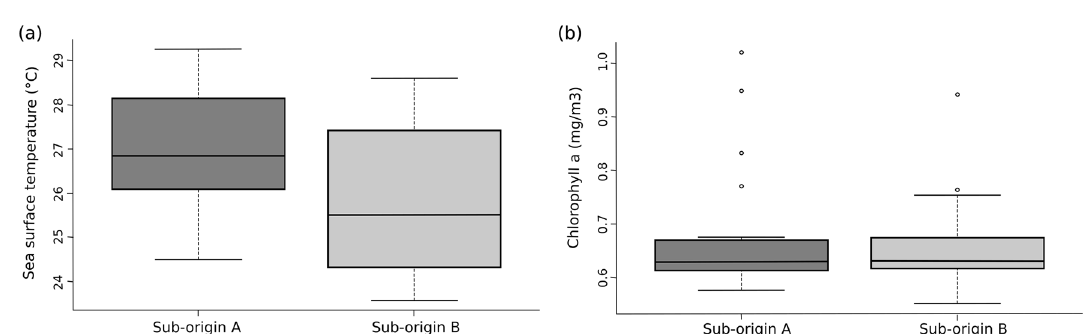
Figure 5. Ternary plots showing morphotype composition of Sargassum samples stranding in Barbados over a 12-month period. Part ( a ) shows Sargassum samples from sub-origin/transport pathway A (March–early August). Part ( b ) shows Sargassum samples from sub-origin/transport pathway B (late August–February). Sargassum natans I (SNI), S. natans VIII (SNVIII) and S. fluitans III (SFIII). Samples are represented by yellow dots and the mean value is represented by a green square.